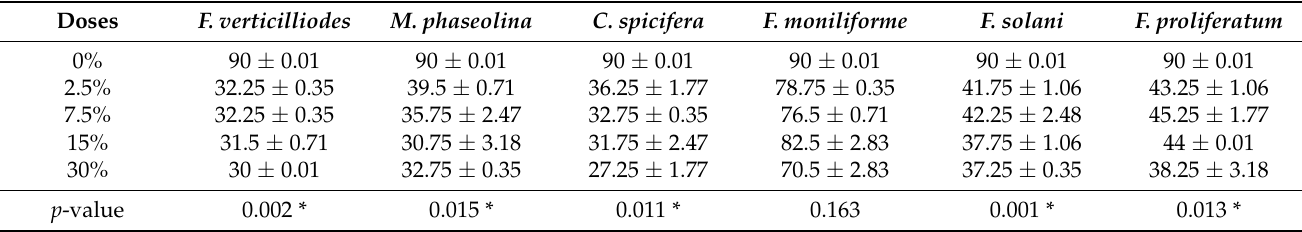
Figure 3. Effect of different concentrations (0, 2.5, 7.5, 15, and 30%) of T. aphylla ethanolic extract on growth of different phytopathogenic fungi. The extract showed variable inhibitory effects on the growth of different phytopathogenic fungi cultured on PDA agar medium. Bars indicate the standard error. Table 2. Effect of different concentrations of T. aphylla ethanolic extract on growth of different phytopathogenic fungi.